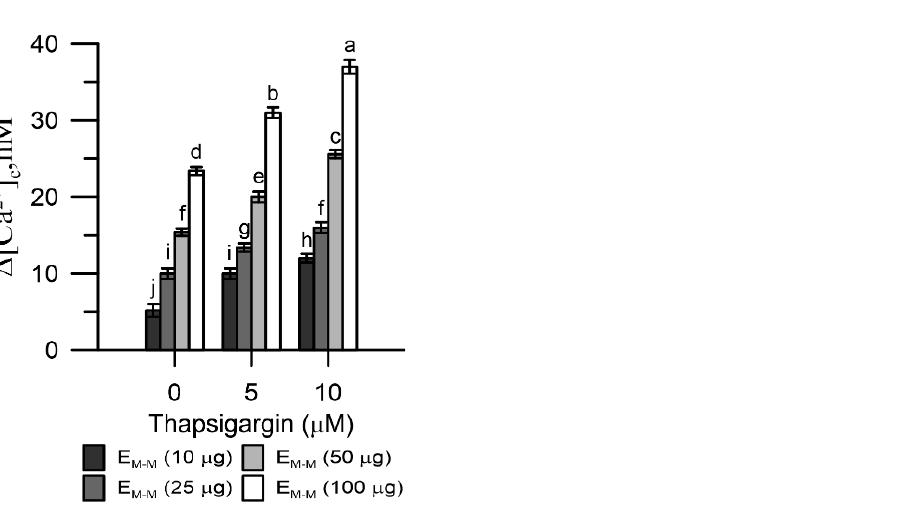
Figure 3. Activity of increasing doses (10–100 µ g) of emmer wheatgrass extracts extracted in methanol and resuspended in methanol (E M-M ) on the cytosolic Ca 2+ of maize pollen in the absence or presence of thapsigargin at 5 and 10 µ M. Data are expressed as means ± SEM from five independent tests. Different letters above bars indicate significant differences at p ≤ 0.05, whereas same letters indicate non-significant differences.